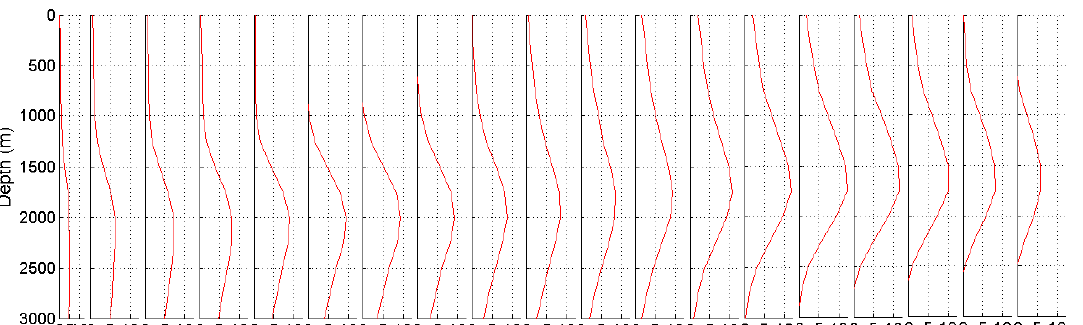
Figure 8. Variation in seismic velocity anomaly as one moves from south to north near the location of well MON-1.The graphs relate to vertical columns through the seismic tomography perturbation model going from 5000 to 9500 m·N at 6000 m·E. Each block in the resampled model domain is a cube with side 250 m. The horizontal axis indicates the magnitude of the anomaly in %. Note also how the magnitude of the anomaly increases from the southern edge to a maximum and then decreases